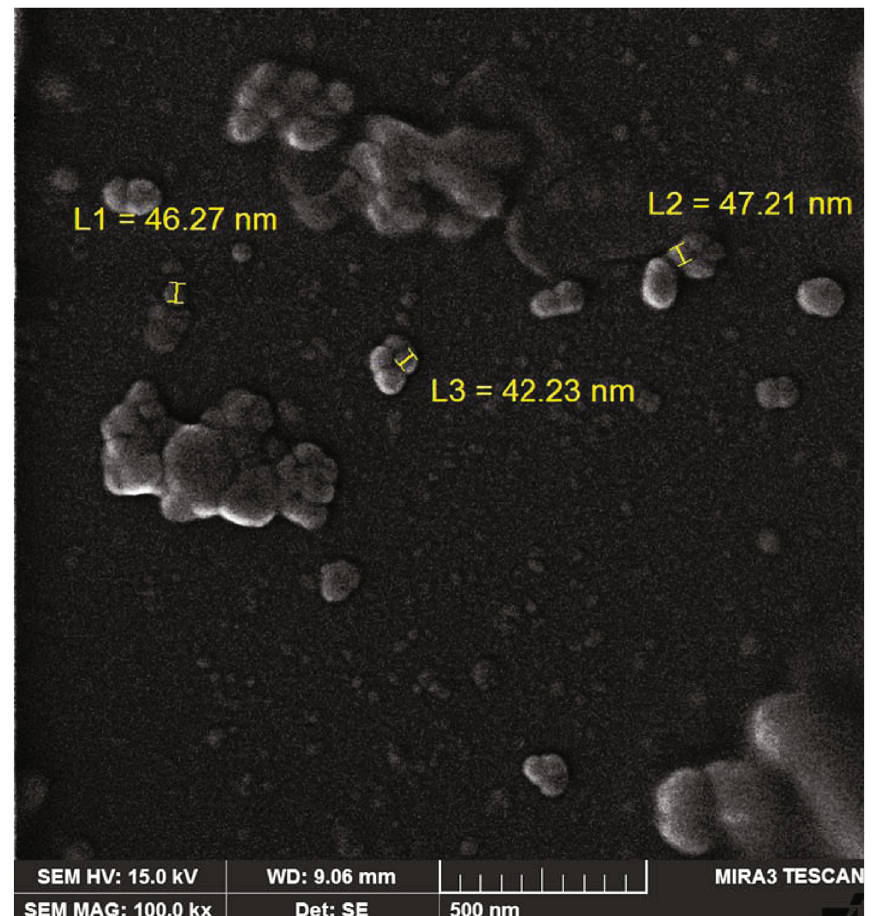
Figure 2: Scanning electron microscopy (SEM) image of